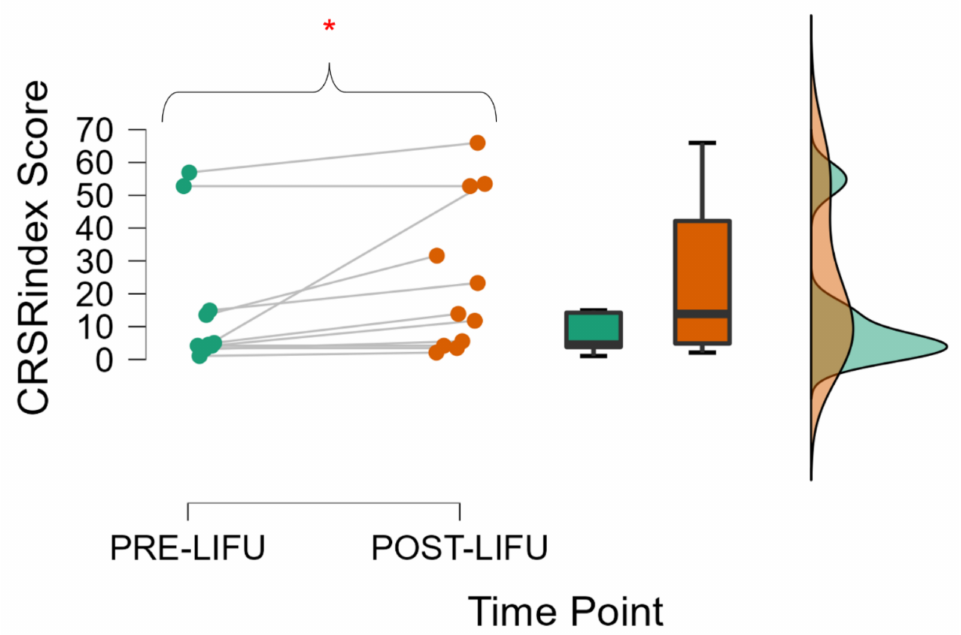
Figure 2. Points, box plots, and distribution of the highest CRS-R index score prior to and up to one week following LIFU. Dashed lines represent the median of each distribution. The red asterisk indicates a significant difference between pre- and post-LIFU